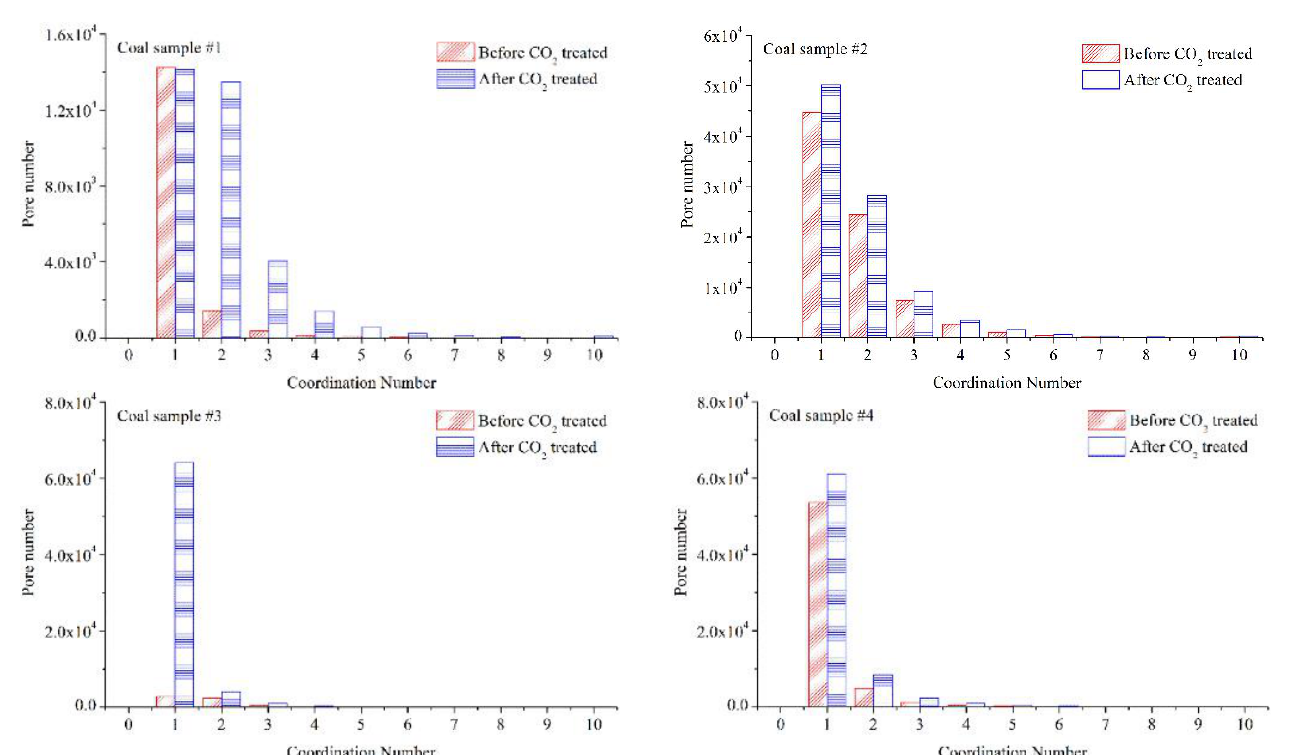
Figure 5—Coordination numbers of coal samples based on X-ray